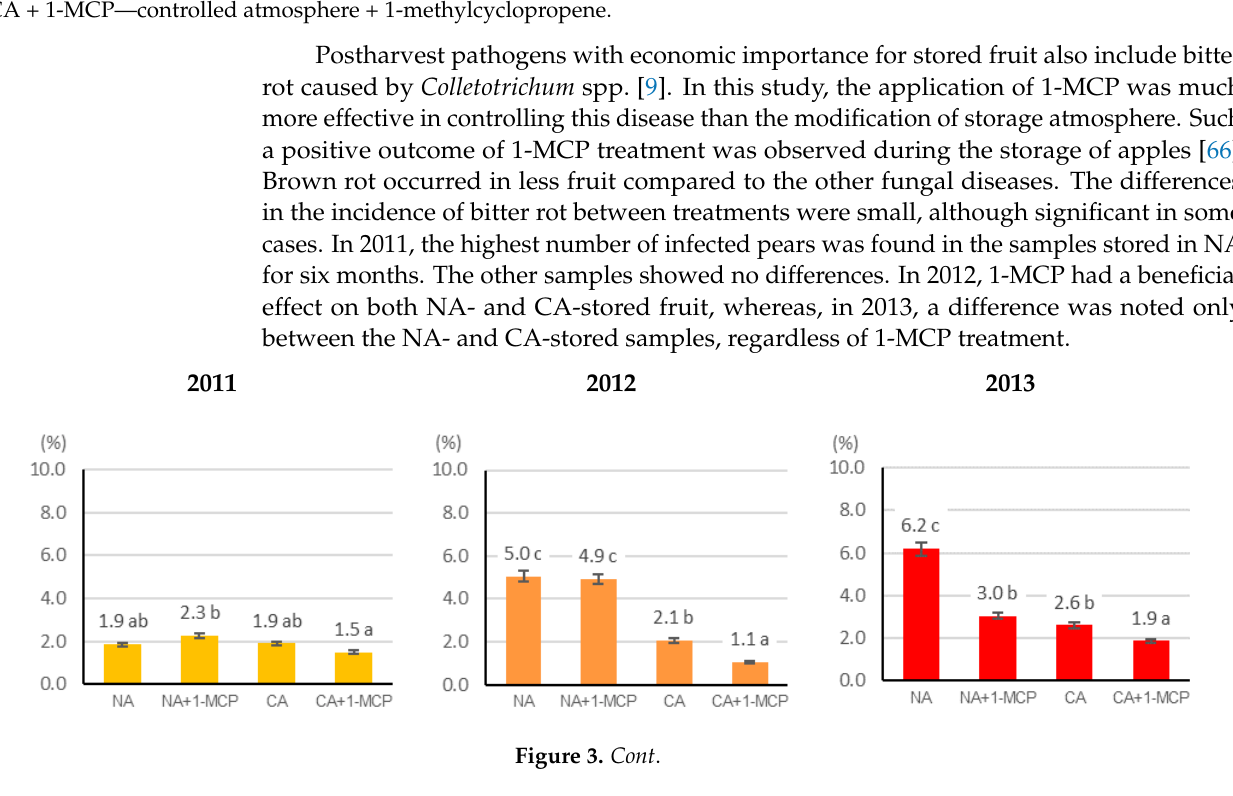
Figure 2. Fungal diseases and physiological disorders after storage in different conditions. Numbers with different letters were significantly different at p = 0.05 according to Duncan’s test. The data are expressed as mean ± SD (n = 10). NA—normal atmosphere; NA + 1-MCP—normal atmosphere + 1-methylcyclopropene; CA—controlled atmosphere; CA + 1-MCP—controlled atmosphere + 1-methylcyclopropene.